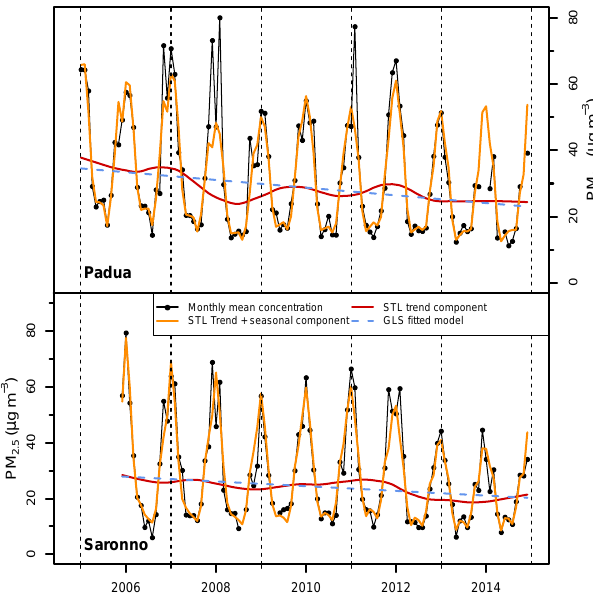
Figure 2. STL decomposition for monthly mean PM 2 . 5 along with generalized least squares (GLS) fitted slope for two selected sites.